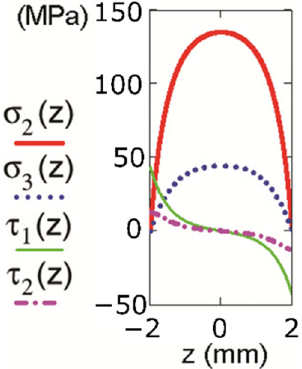
Figure 4. Distribution of normal and shear stresses after fragmentation of the coating (the length of the coating segment is 4 mm).